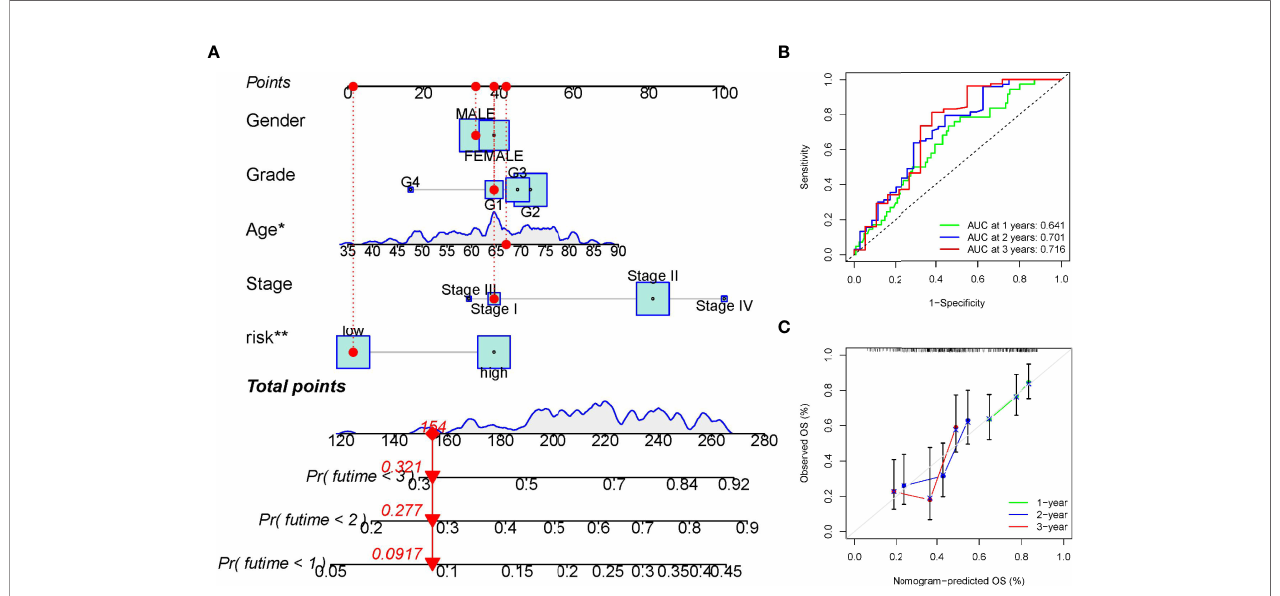
FIGURE 6 | Establishment and veri fi cation of the overall survival nomogram for pancreatic cancer patients. (A) Construction of a nomogram with risk score and clinical characteristics. (B, C) Receiver operating characteristic (ROC) and calibration curve for verifying the accuracy of nomogram. *p < 0.05; **p < 0.01.